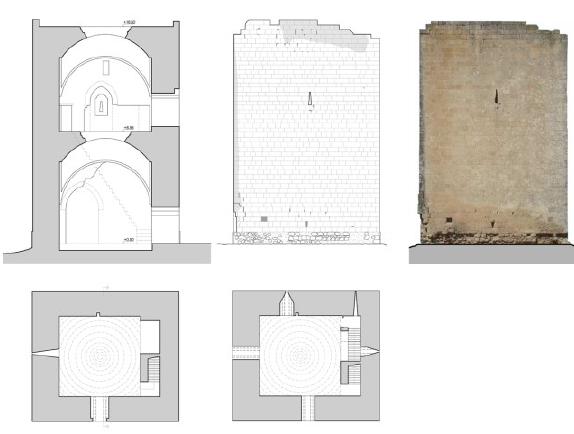
Figure 2: Torre Lopera in Montellano, Seville. Floor plans. Section and photogrammetric